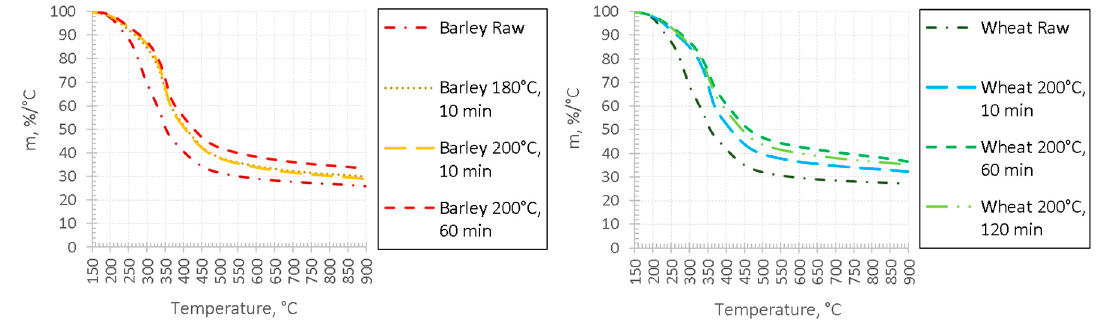
Figure 10. Results of TGA analysis of spent grains from Barley ( left ) and Wheat ( right ) and their respective hydrochars, produced in different HTC conditions (pyrolysis conditions–N 2 ).